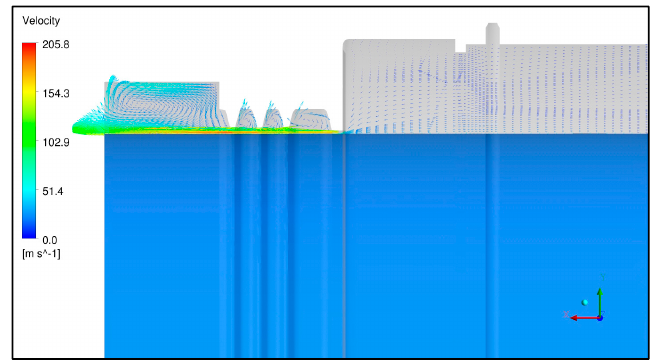
Figure 8. The axial velocity distribution in a longitudinal plane cut for the labyrinth seal at 15,000 rpm with recirculation zones between the fins and flow carry over adjacent to the rotor.